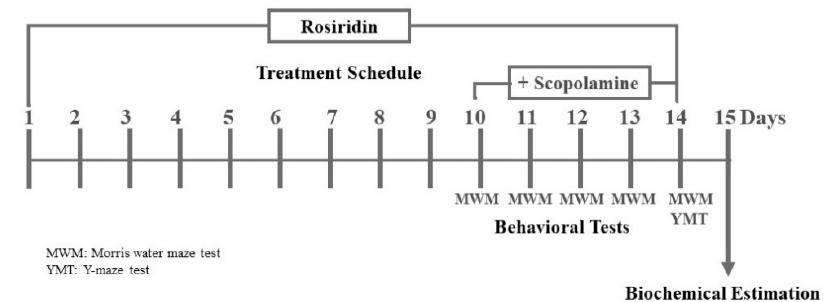
Figure 1. Experimental design .